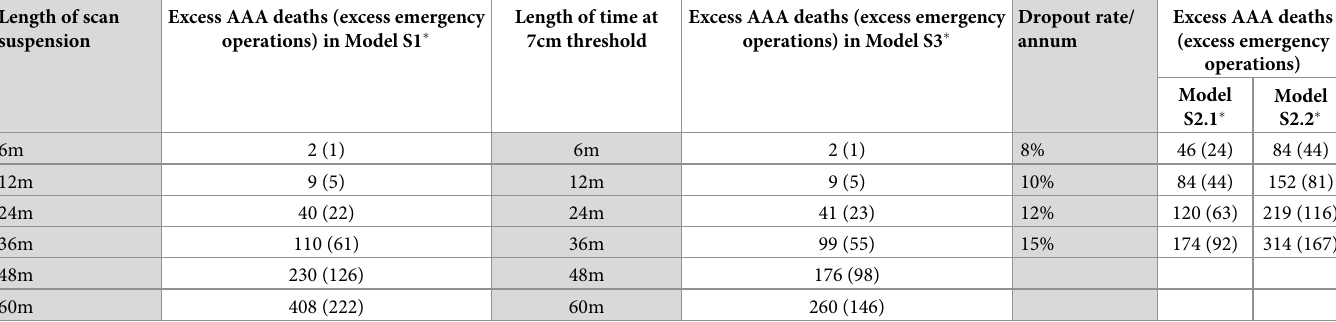
Length of time at Excess AAA deaths (excess emergency 7cm threshold operations) in Model S3 �